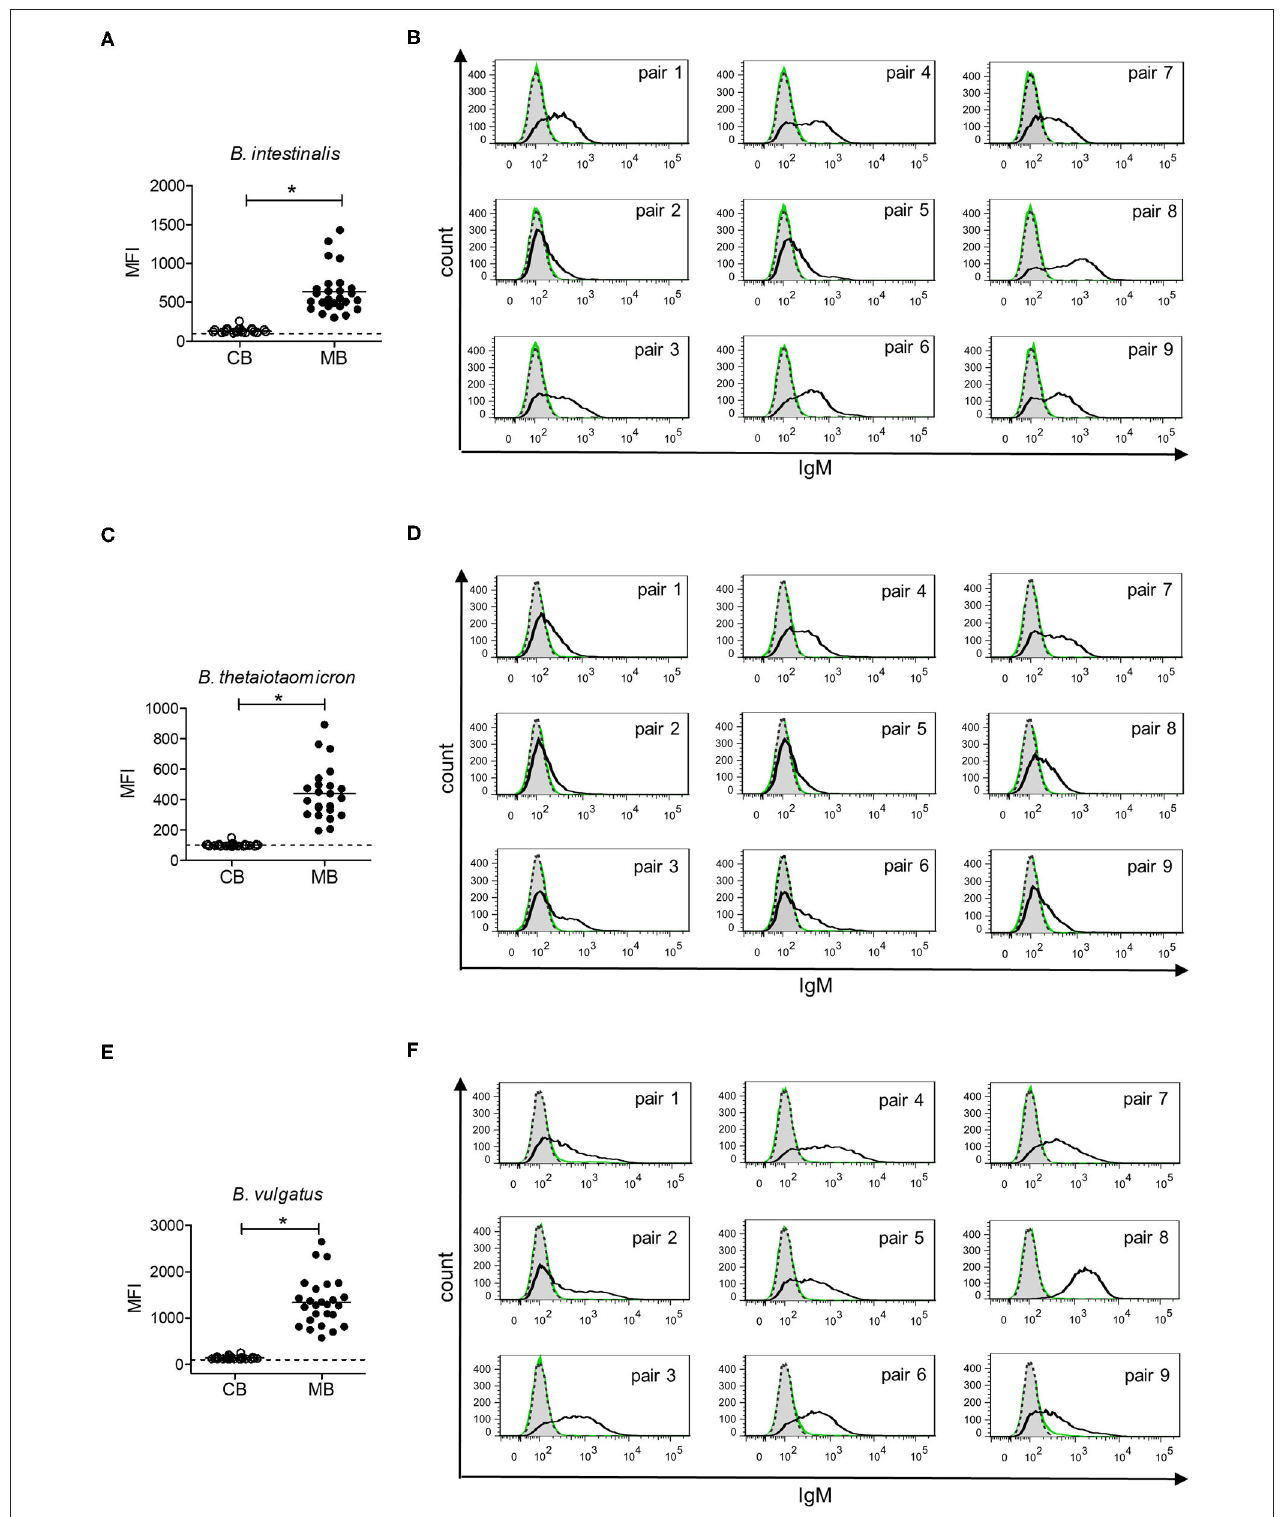
FIGURE 6 | IgM response to commensal intestinal bacteria is absent in cord blood. (A) IgM reactivity to B. intestinalis for cord blood (CB) and maternal blood (MB) samples ( n = 25). (B) IgM reactivity to B. intestinalis for matched pairs of cord blood (green) and maternal blood (black). Untreated bacteria are displayed in